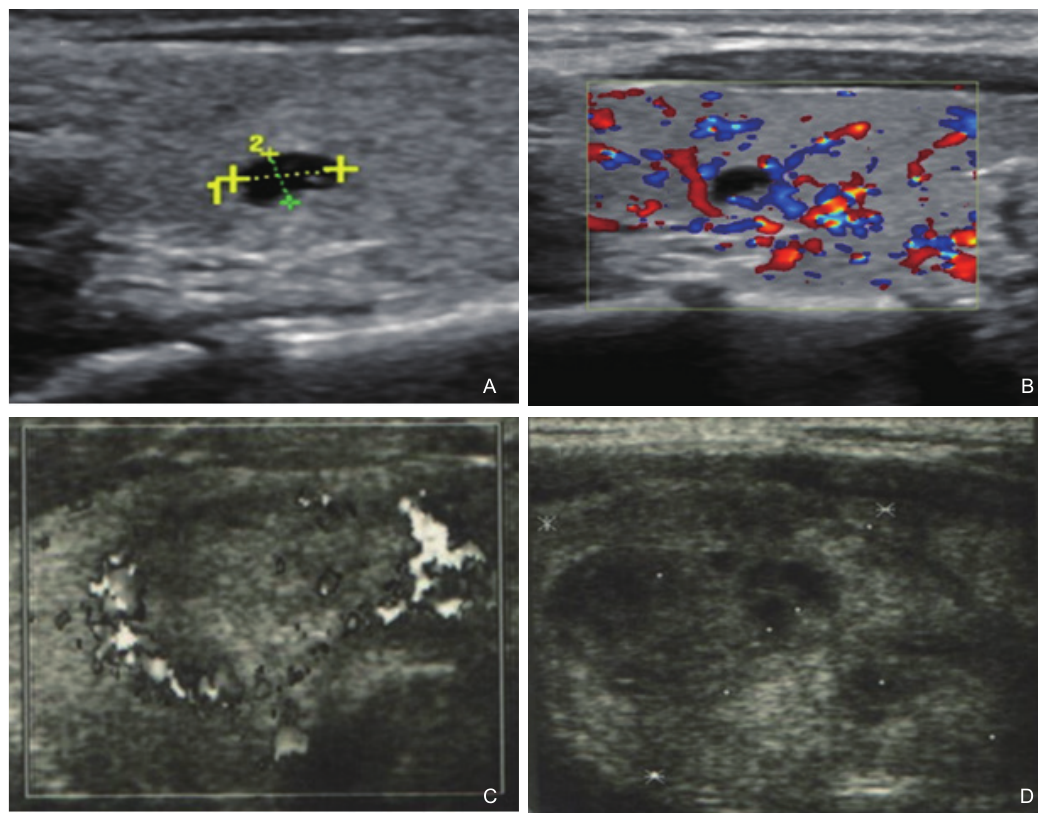
Figure 2 A and B Cystic nodule in a 37-year-old Chinese woman at 21 weeks of gestation. Gray-scale image shows an anechoic lesion of 8 × 5 mm, with a very little intensity of sound waves behind the nodule. Note a strong echo within the nodule, followed by "Comet tail sign" (A). Color-flow Doppler image demonstrates the absence of nodular vascularity (B). C and D: Nodule in 32-year-old Congolese woman in third trimester of gestation. Note the perinodular vascularization on the Color-flow Doppler image (C), and Gray-scale image showing nodule of 45 × 32 mm, with mixed echogenicity. There are some macro calcifications (D). [Images from Shandong Provincial Qianfoshan Hospital, affiliated to Shandong University in China (A and B), and the copy of the report (black-and-white) from University Clinics of Kinshasa in DR. Congo (C and